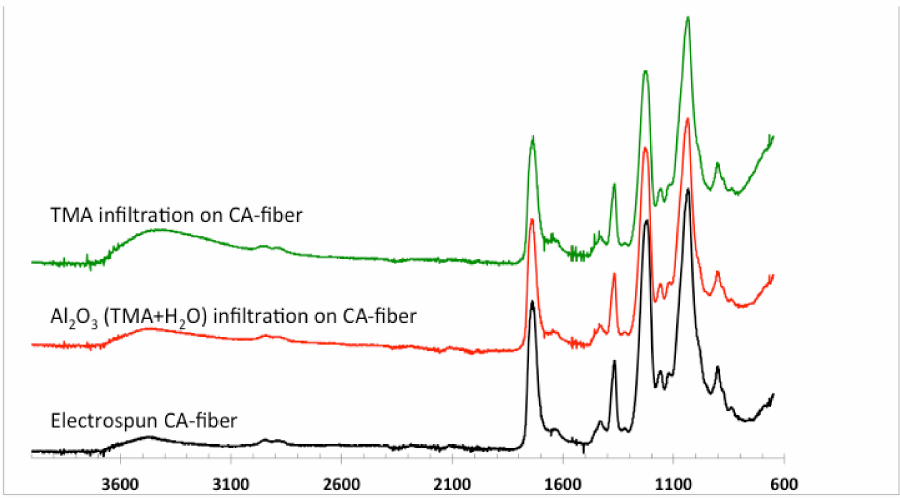
Figure 9. ATR-FTIR spectra of uncoated CA fibres (black), and Al 2 O 3 (red) and TMA (green) infiltrated